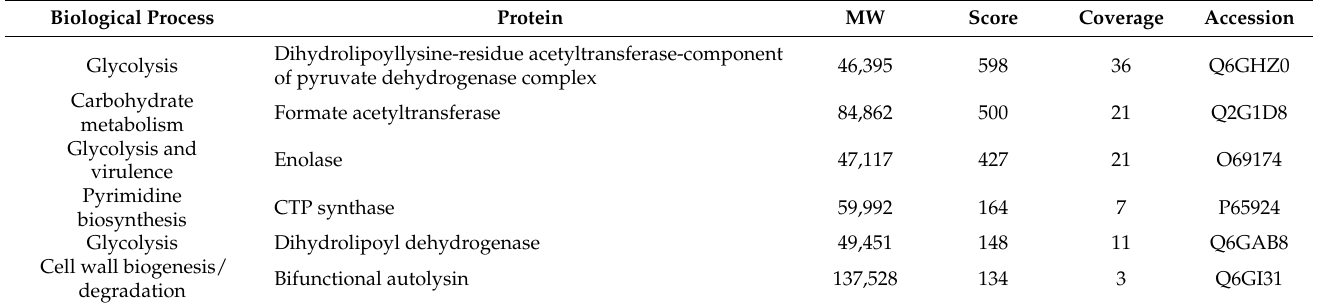
Figure 6. Cargo proteins in membrane vesicles (MVs) obtained from supernatants after different incubation times. MVs prepared from culture supernatants after incubation for 6, 17, and 24 h. Each cargo protein in the MVs was analyzed by SDS-PAGE. The arrows indicate the expression of protein bands that were upregulated (black) or downregulated (white). Table 3. Cargo proteins in MVs with changed expression level after different incubation times.